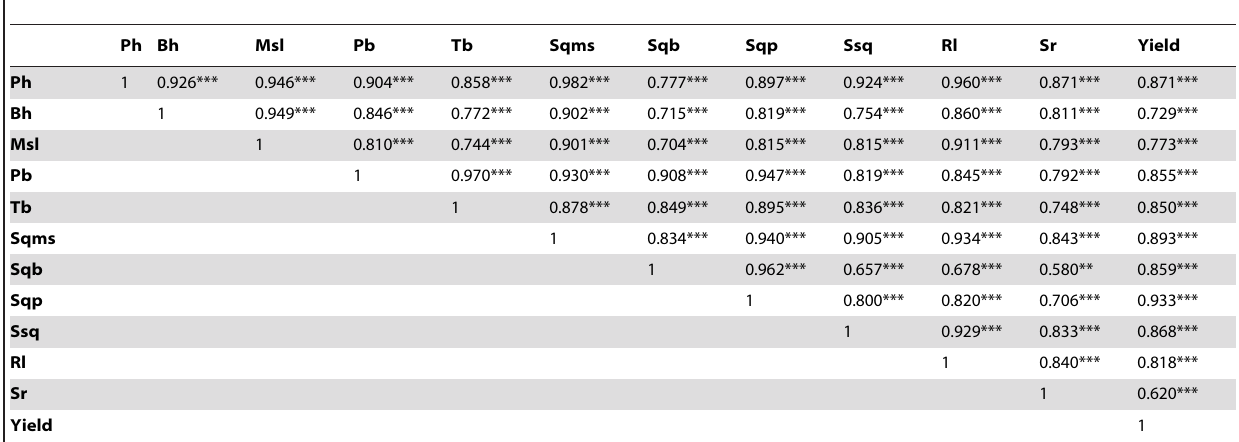
Table 3. Correlation coefficients ( r ) between pairs of WTC of yield related